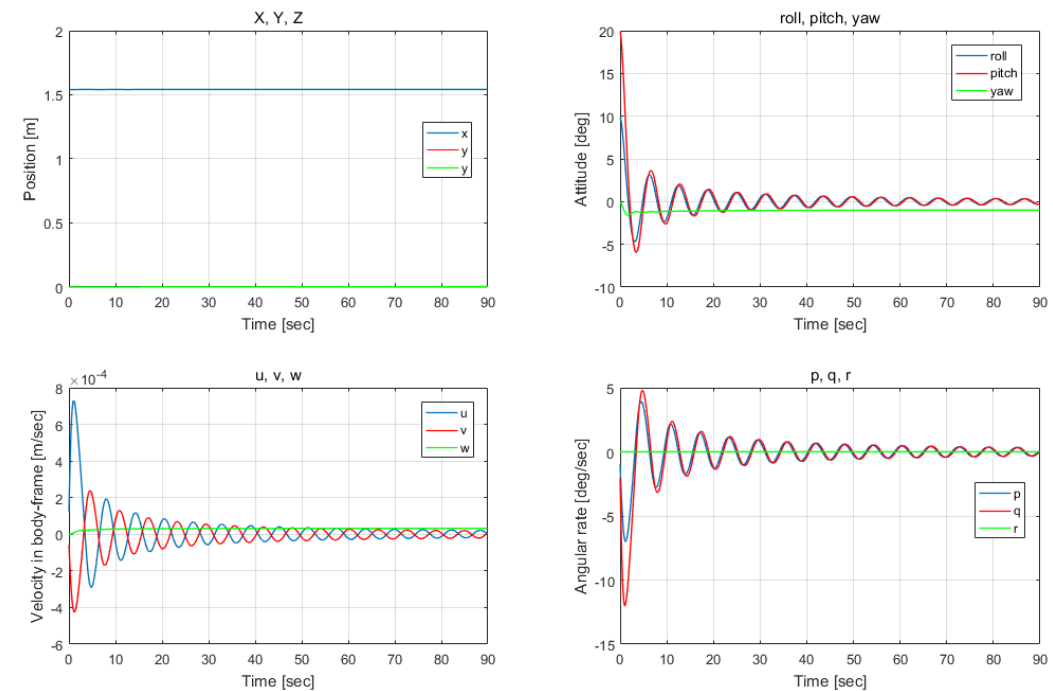
Figure 6. Simulation result of self-stabilization capability.